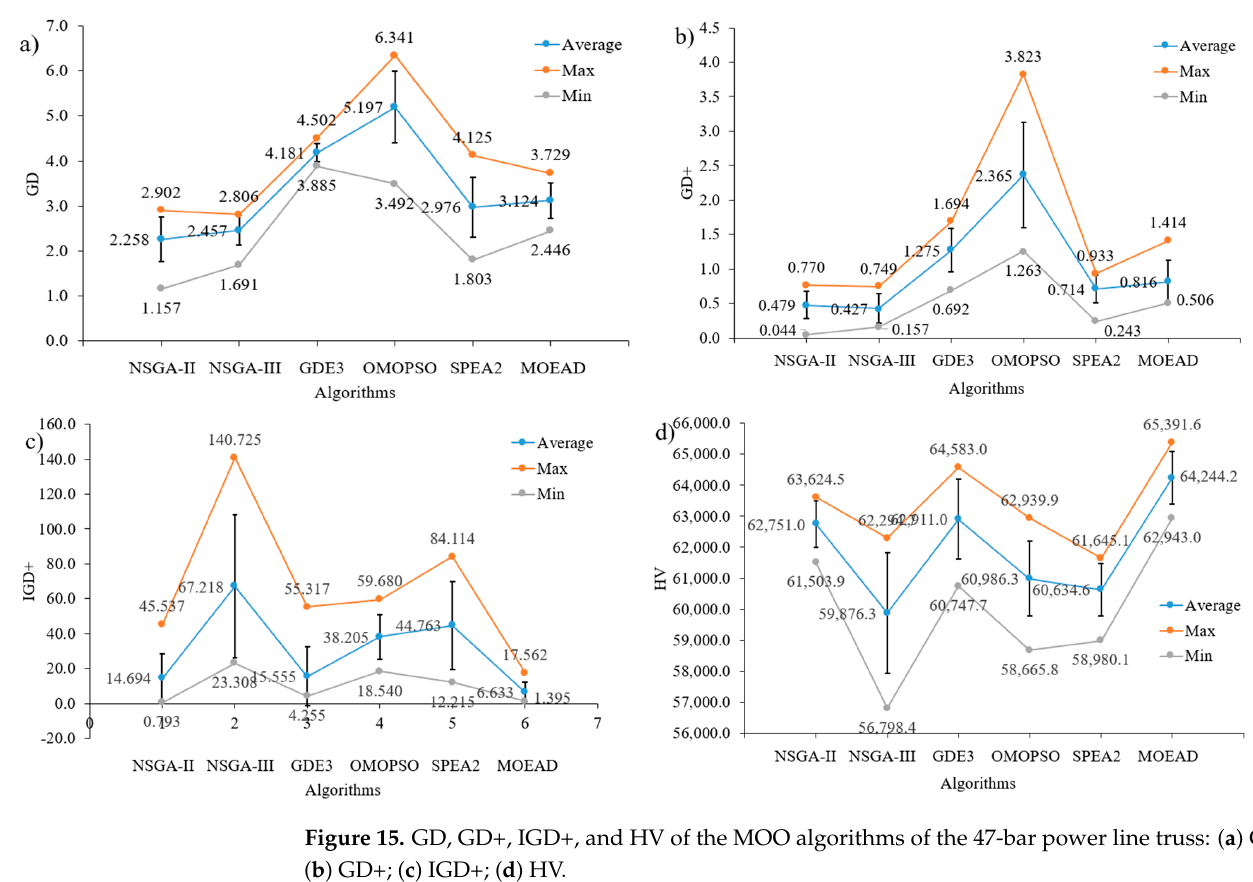
Figure 15. GD, GD+, IGD+, and HV of the MOO algorithms of the 47-bar power line truss: ( a ) GD; ( b ) GD+; ( c ) IGD+; ( d ) HV.